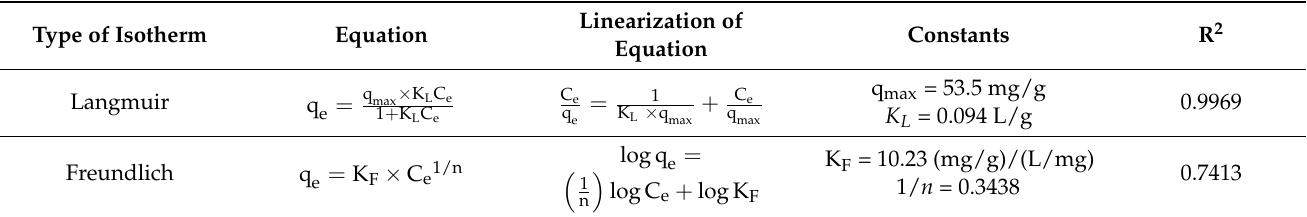
Table 4. Adsorption isotherm constants.